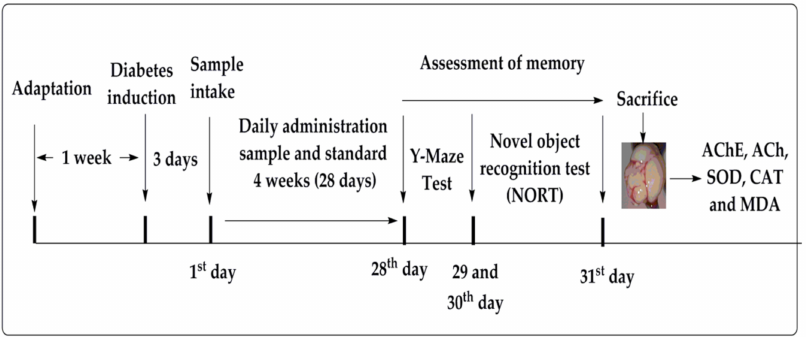
Figure 5. Experimental procedure employed for the assessment of memory in STZ-induced diabetic